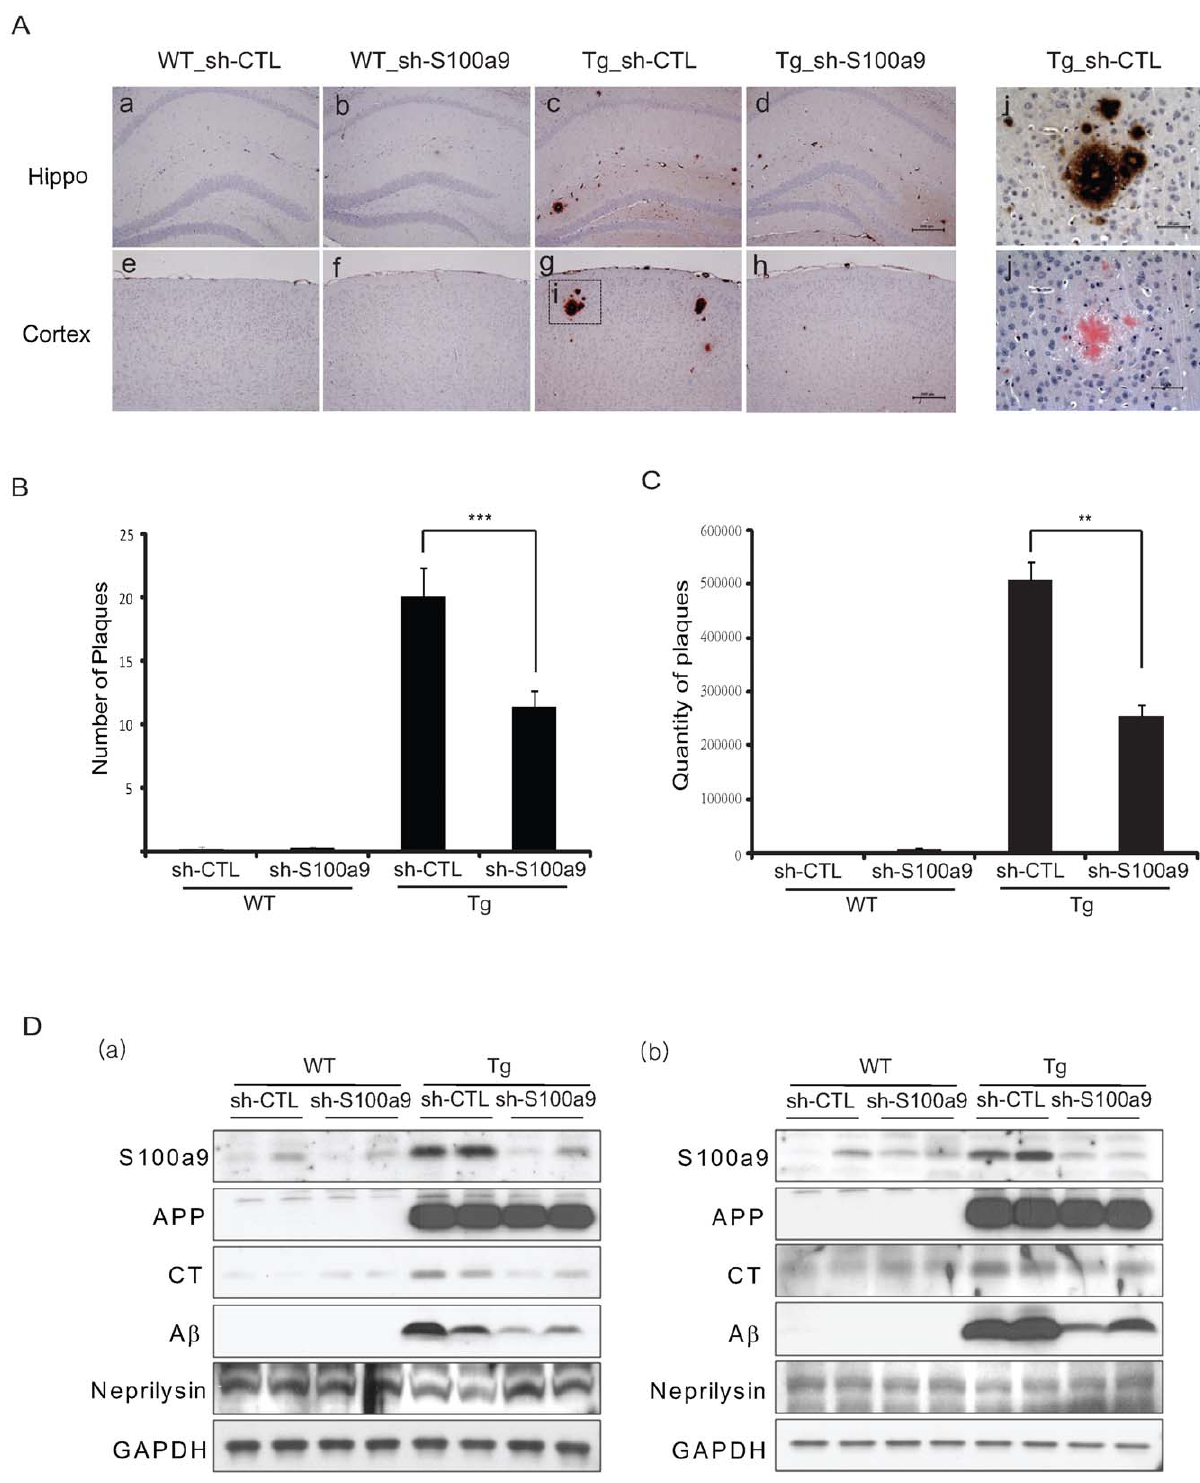
Figure 5. S100a9 knockdown reduced the number of amyloid plaques in Tg2576 mouse brains. At 2 months after lentiviral infection, immunostaining and western blot analyses were performed. (A) Immunostaining with 6E10 antibody for the detection of amyloid plaque in the mouse brain of Hippocampus (Hippo) and Cortex. Higher-magnification view of box in (g) is shown in (i). (j) is Congo red stained image of (i). Scale bars represent 200 m m in (d&h) and 50 m m in (i&j). (B) The number of plaques was counted in whole brain of each group (n=10). ***P , 0.001 by Student’s t- test (C) Size and density of plaques was measured by Multi-Gauge program (version 3.0) in whole brain of each group (n=10). Results are presented as the means of (QL-BG) 6 SEM. **P , 0.01 by Student’s t- test. (D) Western blot analysis was performed with total lysates from the cortical region (a) or hippocampus region (b) of the brains in each group using C9 for APP and CT, 6E10 for A b , anti-Neprilysin or anti-GAPDH antibody. All data represent the means 6 SEM from at least five independent experiments.